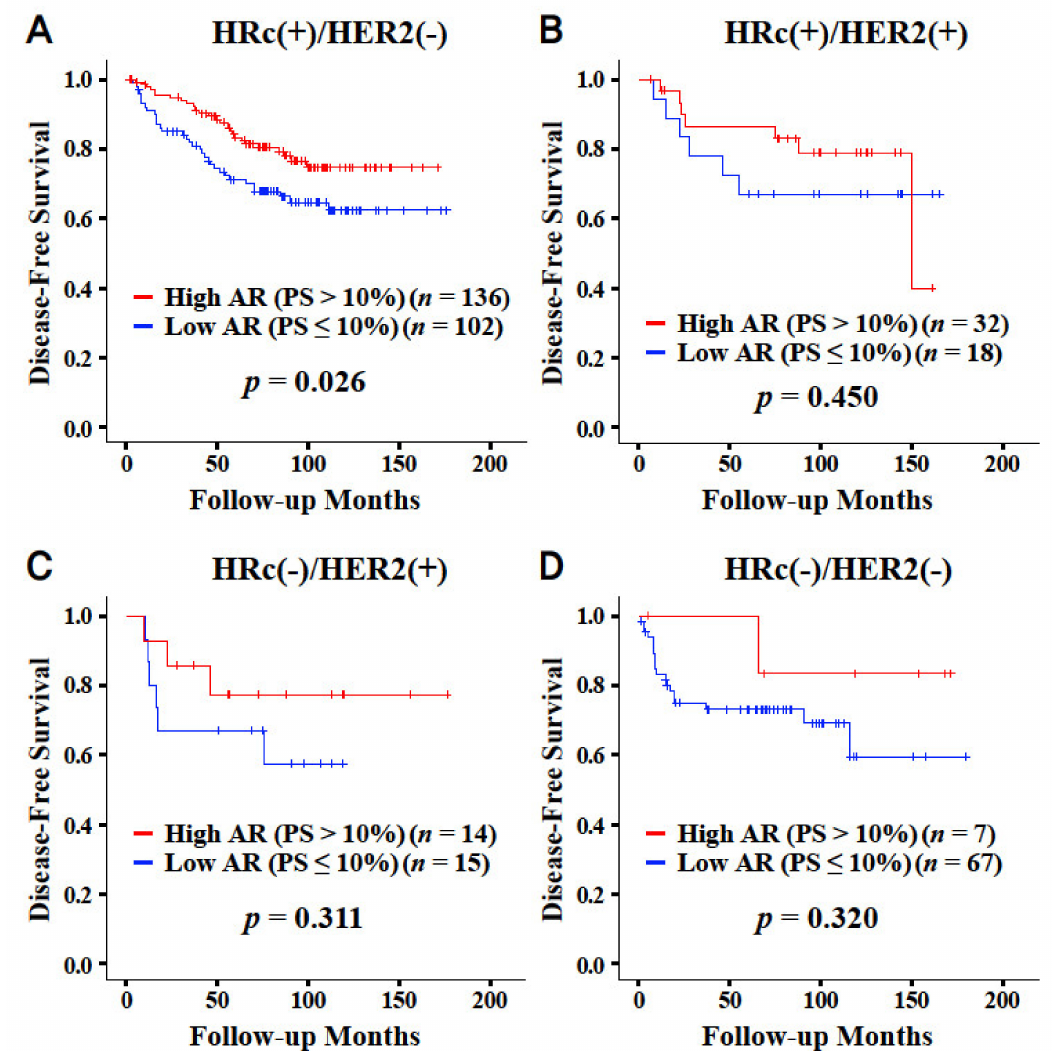
Figure 3. Disease-free survival curves according to the proportion score with the cut-o ff value of 10% by immunohistochemistry regarding AR. Curves in the subtype of HRc( + ) / HER2(-) ( A ), HRc( + ) / HER2( + ) ( B ), HRc(-) / HER2( + ) ( C ), and HRc(-) / HER2(-) ( D ), respectively. Abbreviation: AR, androgen receptor; HER2, human epidermal growth factor receptor 2; HRc, hormone receptor; PS, proportion